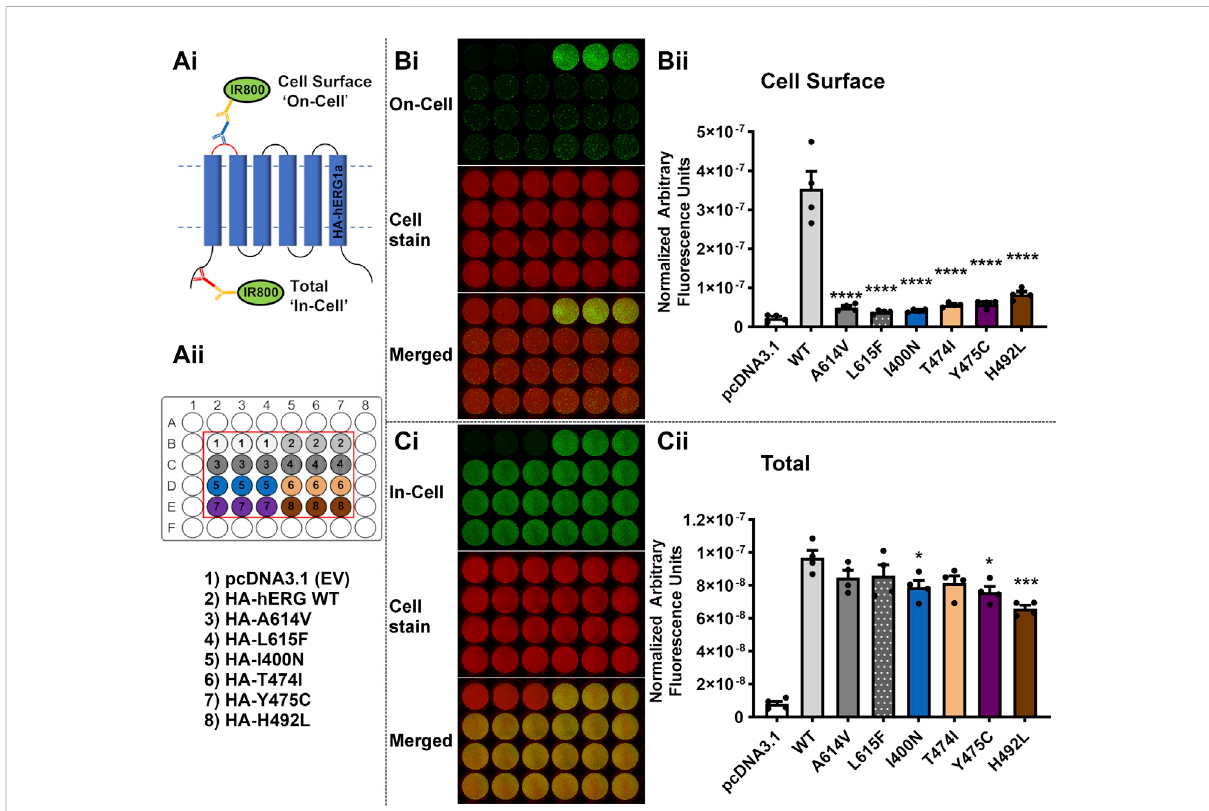
FIGURE 5 The variants I400N, T474I, Y475C and H492L severely perturb traf fi cking of the hERG channel. (Ai) : Diagram depicting the experimental setup for Cell Surface ( ‘ On-Cell ’ ) and Total channel protein detected (Total) ( ‘ In-Cell ’ ) Western assays. (Aii) : Diagram of the assay design and key for transfectionconditionsfortheassaysdisplayedin (Bi,Ci) .EV=emptyvector;WT=Wild-Type. (Bi): ‘ On-Cell ’ CellSurfacehERGchannelexpressionof the test variants I400N, T474I, Y475C and H492L compared to the WT channel and positive control variants A614V and L615F. Representative ‘ On-Cell ’ CellSurfacehERGchannelexpressionassayimagesareshown.Theupperpanel(greenchannel)showsthe ‘ On-Cell ’ CellSurfacesignalfor hERGexpression.Themiddle panel (redchannel) representscells stainedwithWGA-680andthebottompanel isthemergedimage. (Bii) Quanti fi ed Cell Surface expression levels of the WT channel, positive controls, and test variants. (Ci) ‘ In-Cell ’ Total cellular hERG channel protein for the test variants I400N, T474I, Y475C and H492L compared to the WT channel and positive control variants A614V and L615F. Representative ‘ In-Cell ’ Total hERG channel protein assay images are shown. The upper panel (green channel) shows the ‘ In-Cell ’ Total hERG channel protein detected. The middle panel (redchannel)represents cells stained with WGA-680and the bottom panel isthemergedimage. (Cii) Quanti fi edTotal channel protein values for the WT channel, positive controls, and test variants. Data are presented as (mean ± SEM) from four independent repeats [individual data points are displayed in (Bii,Cii) ]. Statistical analyses were performed using one way analysis of variance (ANOVA) and Bonferroni ’ s multiple comparison. Asterisks indicate a signi fi cant difference from the corresponding WT value (**** = p < 0.0001; *** = p < 0.001; ** = p < 0.005; * = p <